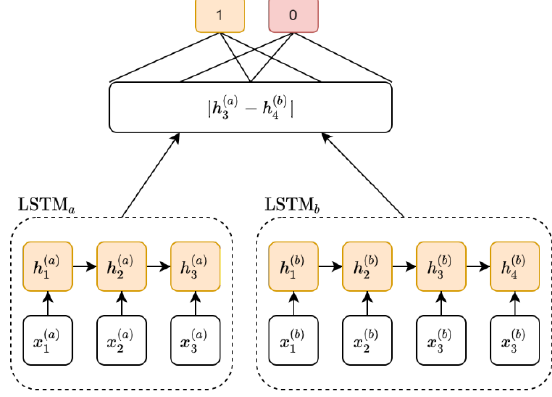
Fig. 3. Illustration of Siamese-Classifier